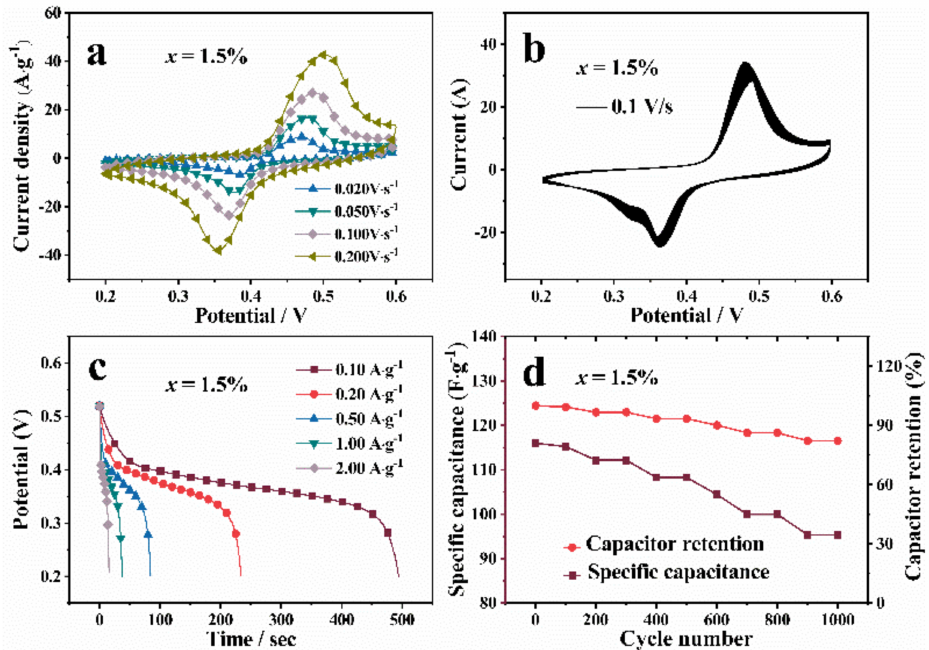
Figure 7. The Electrochemical measurements of Zn-VO 2 (B) sample with x = 1.5%: ( a ) CV curves at different scan rates; ( b ) CV curves of 1000 cycles at 100 mV/s scanning rate; ( c ) galvanostatic discharge profiles at different current density; ( d ) cycling performances at 0.1 A · g − 1